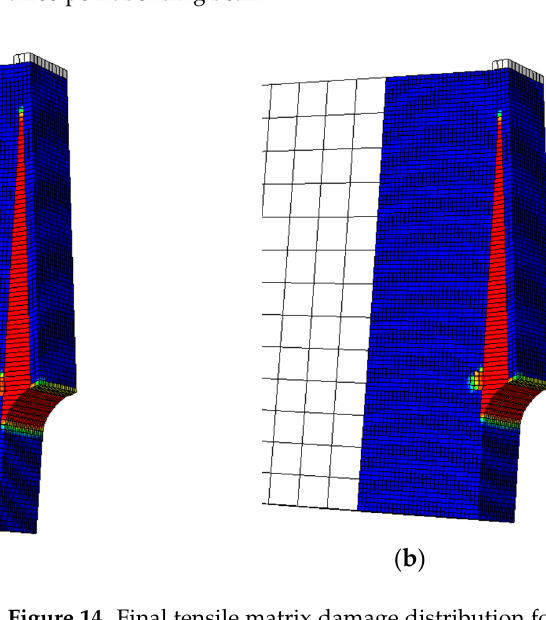
Figure 13. Tensile matrix damage vs. principal strain ( a ), shear damage vs. principal strain ( b ), and tensile fiber damage ( c ) vs. principal strain over integration points 1 and 2 with ITE algorithm for the three-point bending beam.